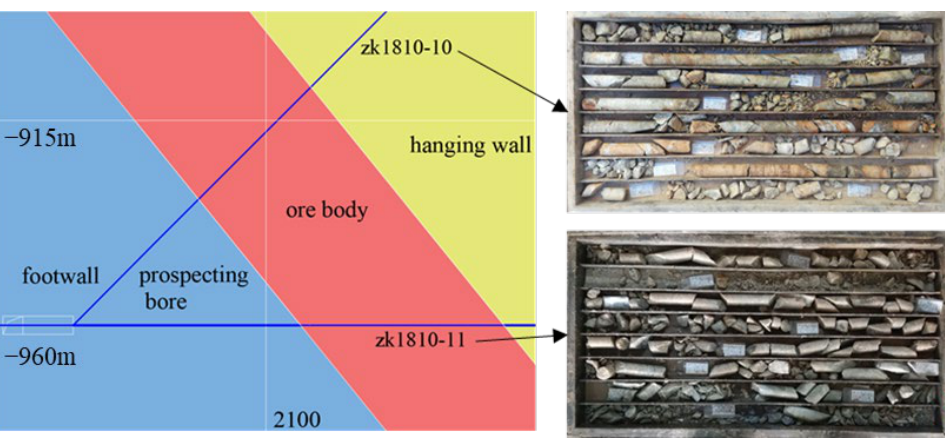
Figure 9. RQD calculation from exploration drill core.